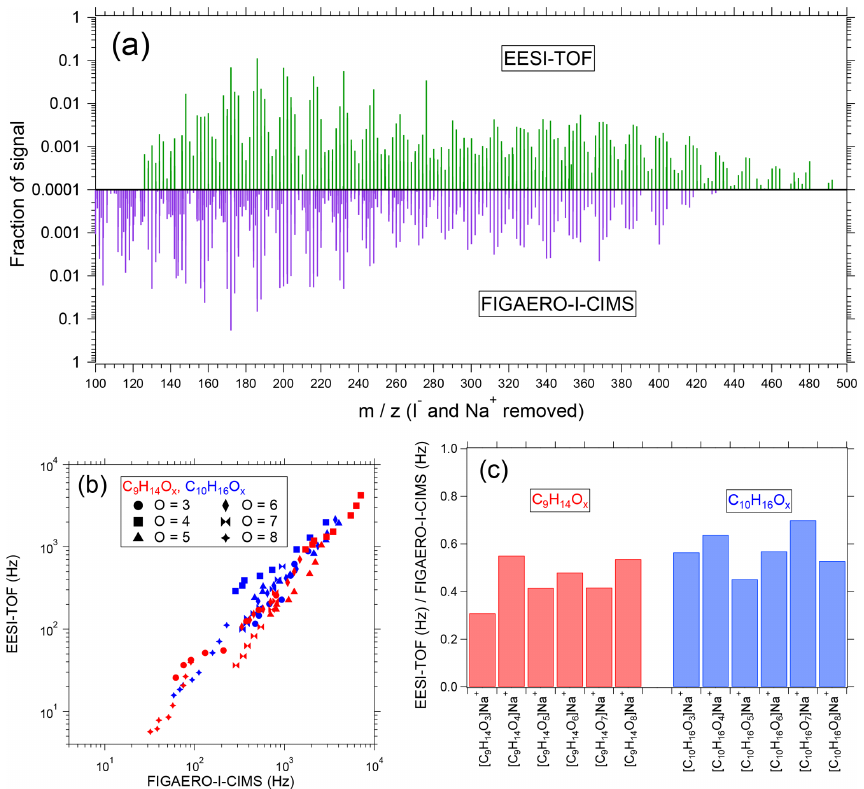
Figure 5. (a) Particle-phase mass spectra of SOA from α -pinene ozonolysis measured by the EESI-TOF (top, green) and FIGAERO-I- CIMS (purple, bottom). Spectra are normalized such that the sum across the displayed m/z window is 1, and the reported m/z values are after subtraction of Na + (EESI-TOF) and I − (FIGAERO). (b) EESI-TOF signal (Hz) as a function of FIGAERO-I-CIMS (Hz) for the [ C 9 H 14 O x ] Na + (red) and [ C 10 H 16 O x ] Na + (blue) ion series. Marker shape denotes number of oxygen atoms. (c) Slopes of linear fits to individual ions for the [ C 9 H 14 O x ] Na + (red) and [ C 10 H 16 O x ] Na + (blue) ion series. All fits are conducted using orthogonal distance regression with unconstrained intercepts.